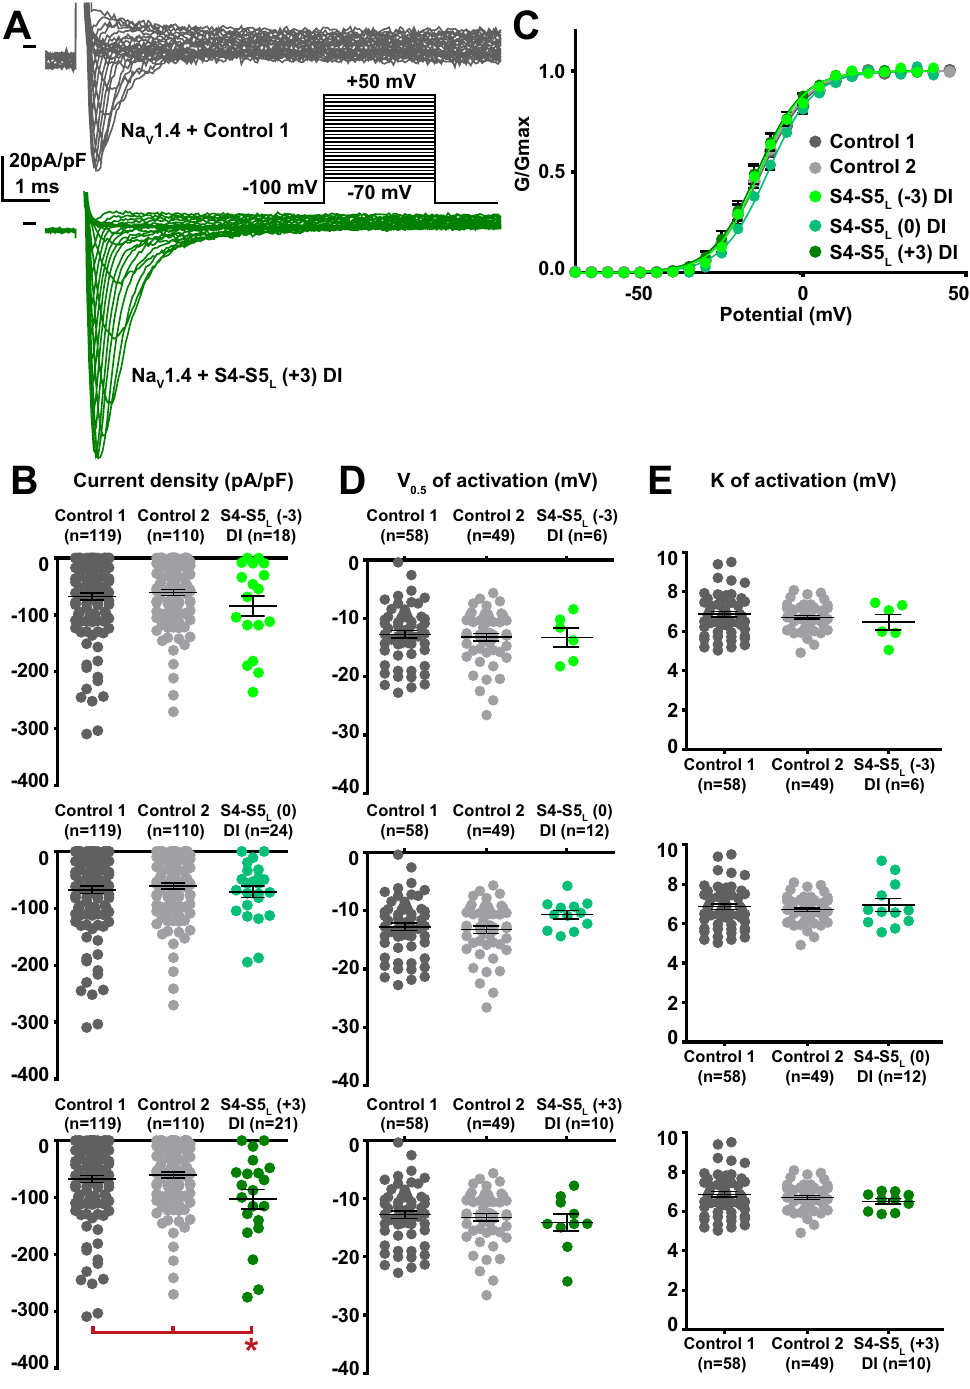
Figure 5. Effect of Na V 1.4 S4-S5 L mimicking peptides of domain I on Na V 1.4 current density and activation curve. ( A ) representative, superimposed current recordings in COS-7 cells co-transfected with Na V 1.4, Na V ß1, and control 1 (top trace) or domain I S4-S5 L ( + 3) peptide (bottom trace). Inset: activation voltage protocol used (holding potential: − 100 mV; 30-ms pulse; one sweep every 2 s). ( B) Dot plot and mean ± sem of peak Na V 1.4 current densities recorded in COS-7 cells co-transfected with Na V 1.4, Na V ß1, and the indicated peptide, at 0 mV. C: Relative peak conductance versus membrane potential curves for Na V 1.4 channels in the same cell groups as in ( B) . Lines are Boltzmann fits to the data. ( D , E) Dot plot and mean ± sem of Na V 1.4 half-activation potential (V 0.5 ; D ) and activation slope (K; E ) in the same cells group as in ( B) . * p value vs . both controls <